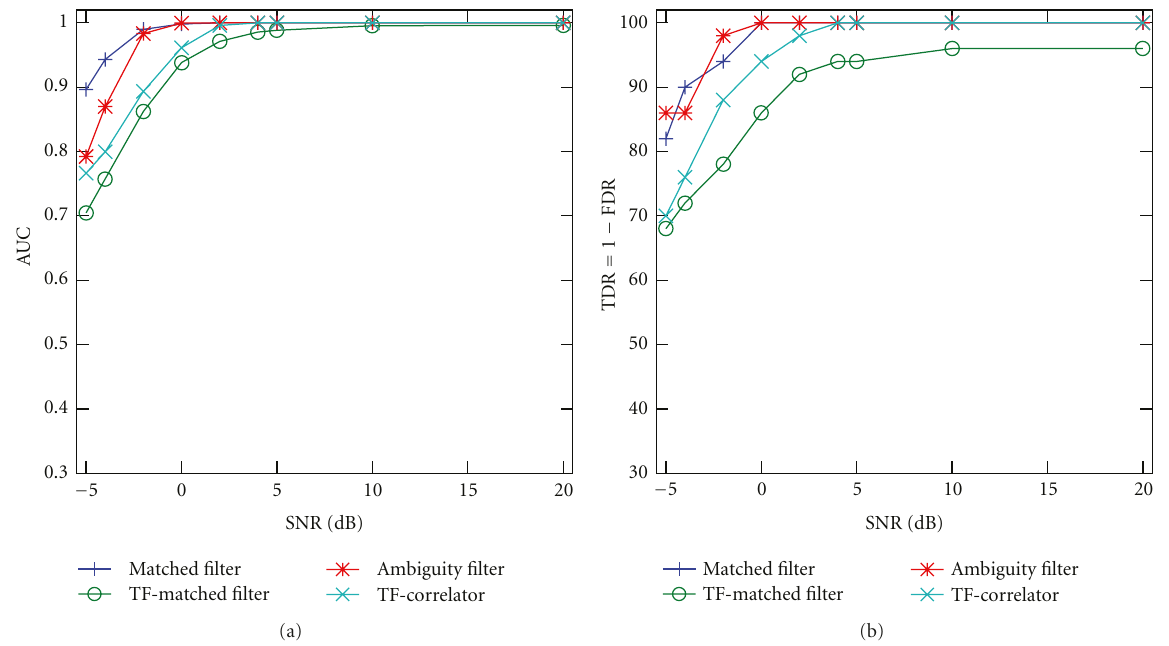
Figure 6: Results for detecting signals in white Gaussian noise with high-energy